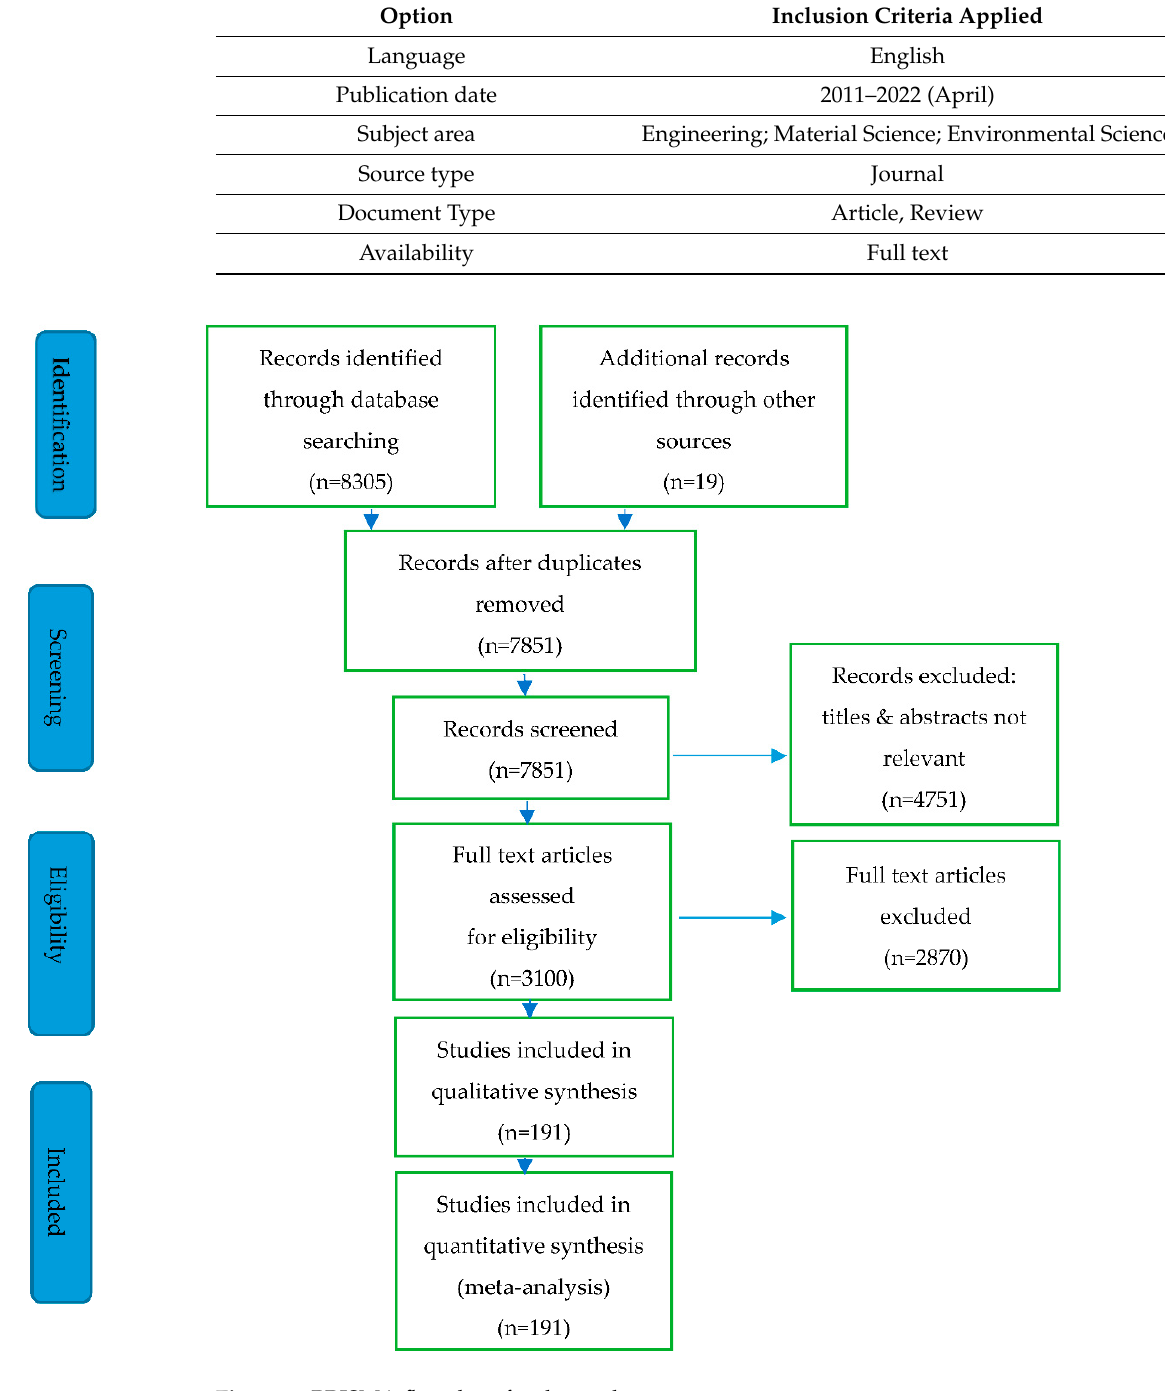
Figure 1. PRISMA flowchart for the study.